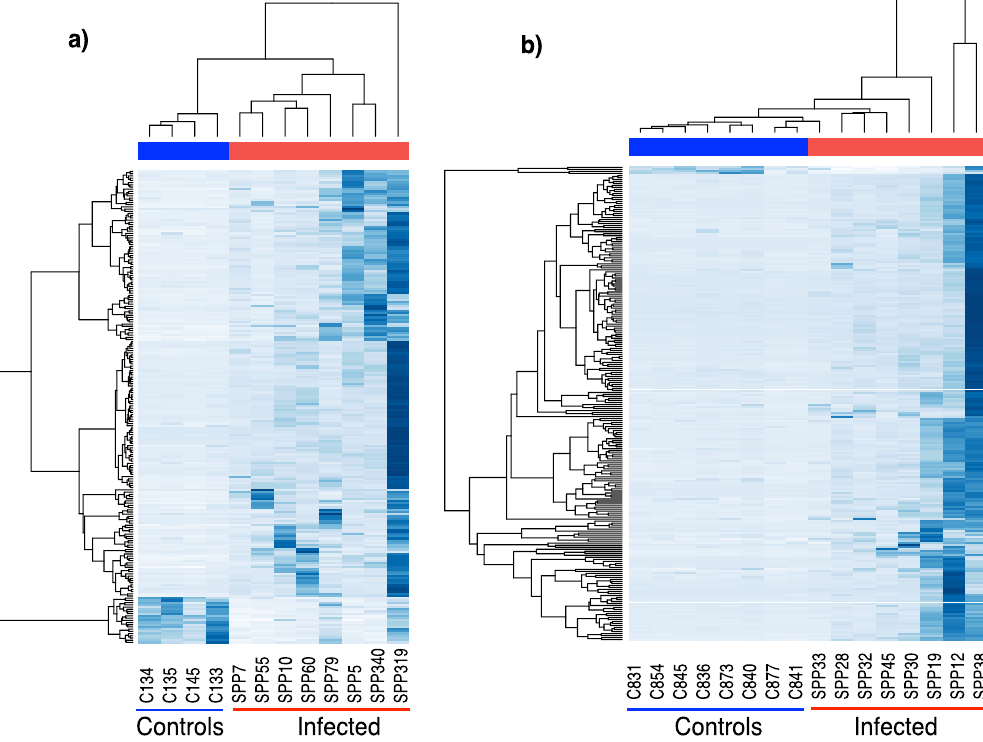
Figure 3. Heat maps and cluster analysis of the quantification of proteins calculated by label free approach. The overall profile of proteins that were analysed in two separate cohorts (a and b panels) of patient and control samples was expressed as a heat map, normalizing the proteome profiles for each sample by calculating the z-score on proteins. Unsupervised clustering analysis was used to segregate the